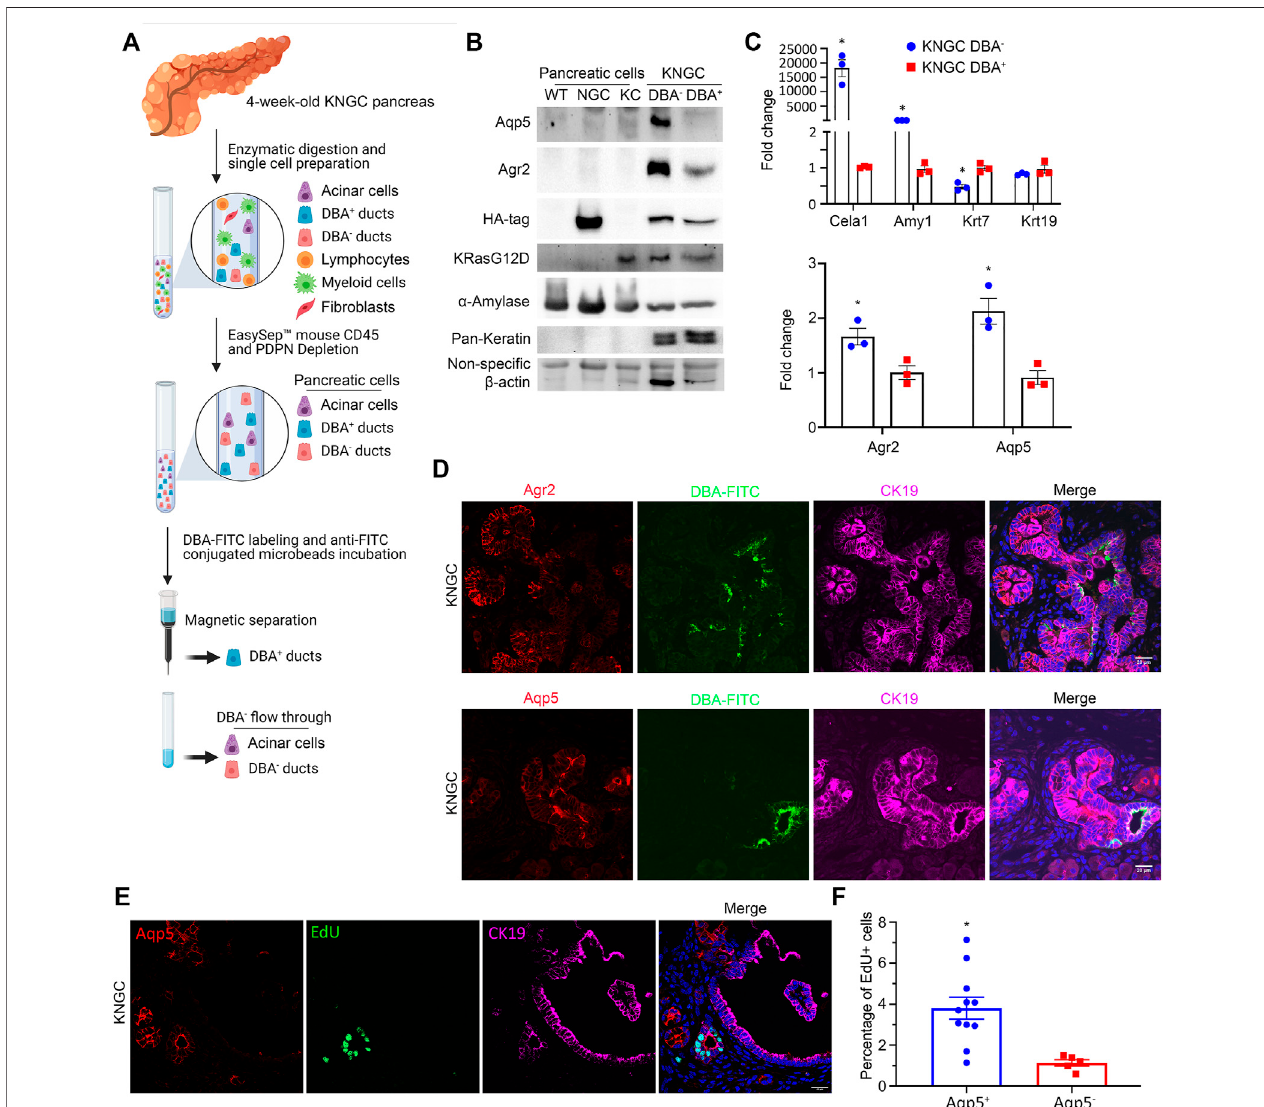
FIGURE 4 | KNGC mice develop two distinct ductal populations. (A) Illustration of the experimental approach to purify lectin-expressing ductal cells through negative selection (anti-CD45 and anti-Podoplanin) and puri fi cation using the lectin-binding protein DBA. (B) Cell lysates from isolated DBA − and DBA + cell pools of fi ve 4-week-old KNGC mice and pancreatic cells from WT, NGC, KC mice were prepared and probed with the indicated antibodies. (C) Real-time PCR quanti fi cation of the indicatedgenesfromisolatedDBA − andDBA + samplesfrom4-week-oldKNGCmice.TBP, β -actin,RPLP0andGAPDHwereusedasinternalhousekeepinggene controls. Data were analyzed and expressed as mean ± SEM. n = 3; p p < 0.05. (D) Immuno fl uorescence staining of Agr2 (red, upper panel) or Aqp5 (red, lower panel) with DBA-FITC (green) from pancreatic sections of 4-week-old KNGC mice. (E) Immuno fl uorescence staining of EdU (green), Aqp5 (red) and CK19 (purple) from pancreatic sections of 4-week-old KNGC mice. (F) Quanti fi cation of EdU positive percentage in Aqp5 positive or negative cells was analyzed and expressed as mean ± SEM. p p < 0.05 EdU positive in Aqp5 positive versus negative cells.